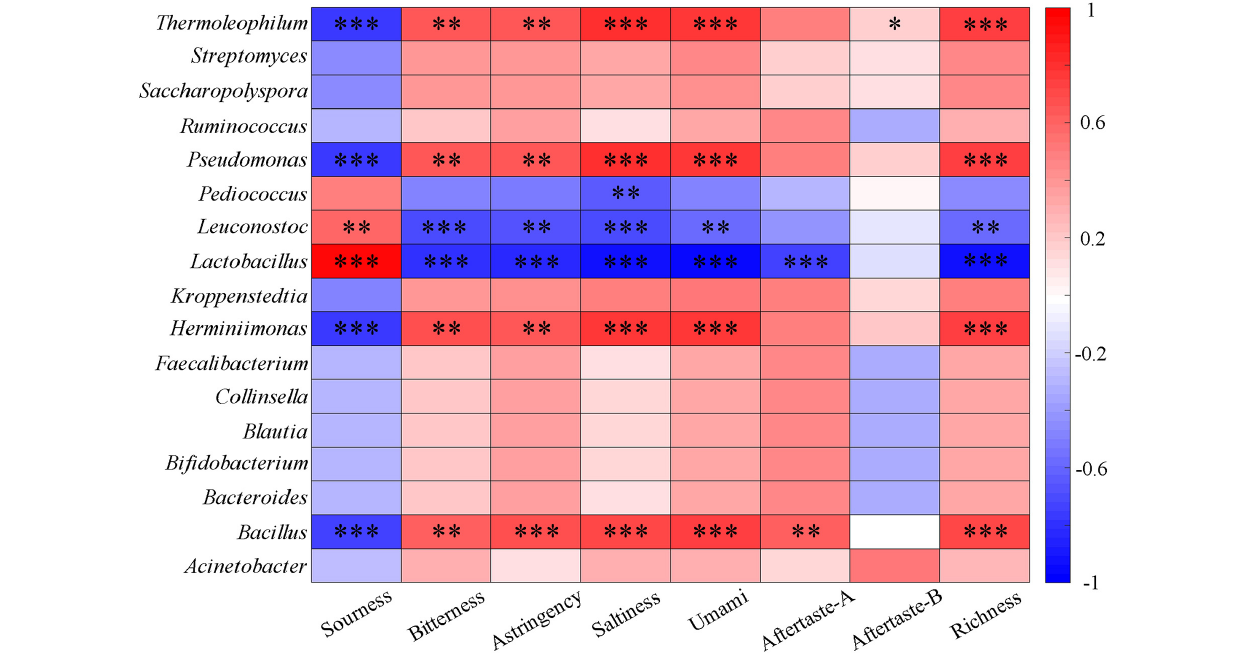
Frontiers in Microbiology |